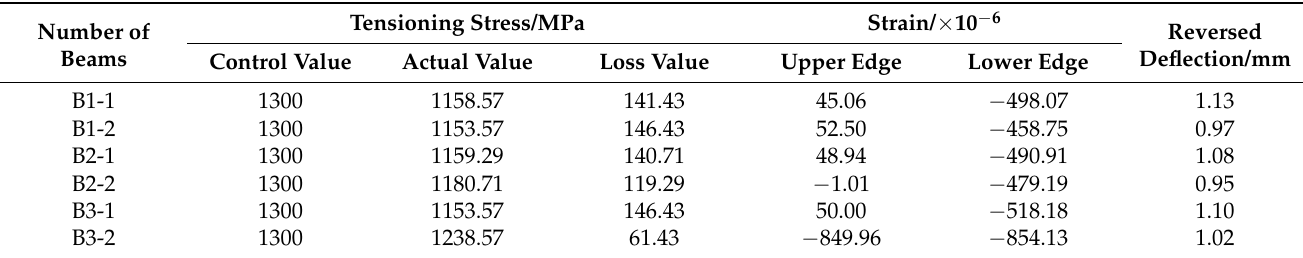
Table 2. The results of the prestress tensioning of each